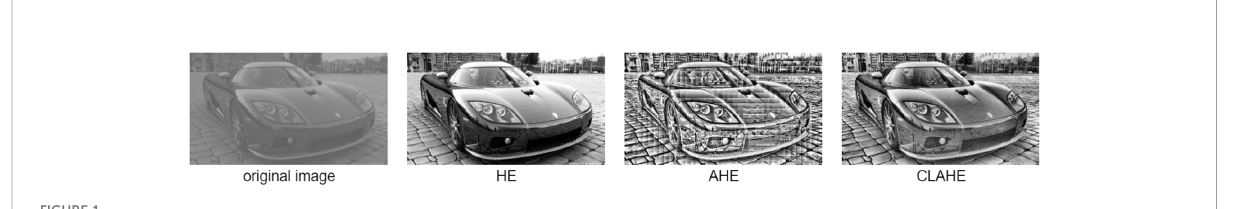
FIGURE 1 Comparison of the histogram equalization (HE), adaptive histogram equalization (AHE), and contrast limited adaptive histogram equalization (CLAHE)